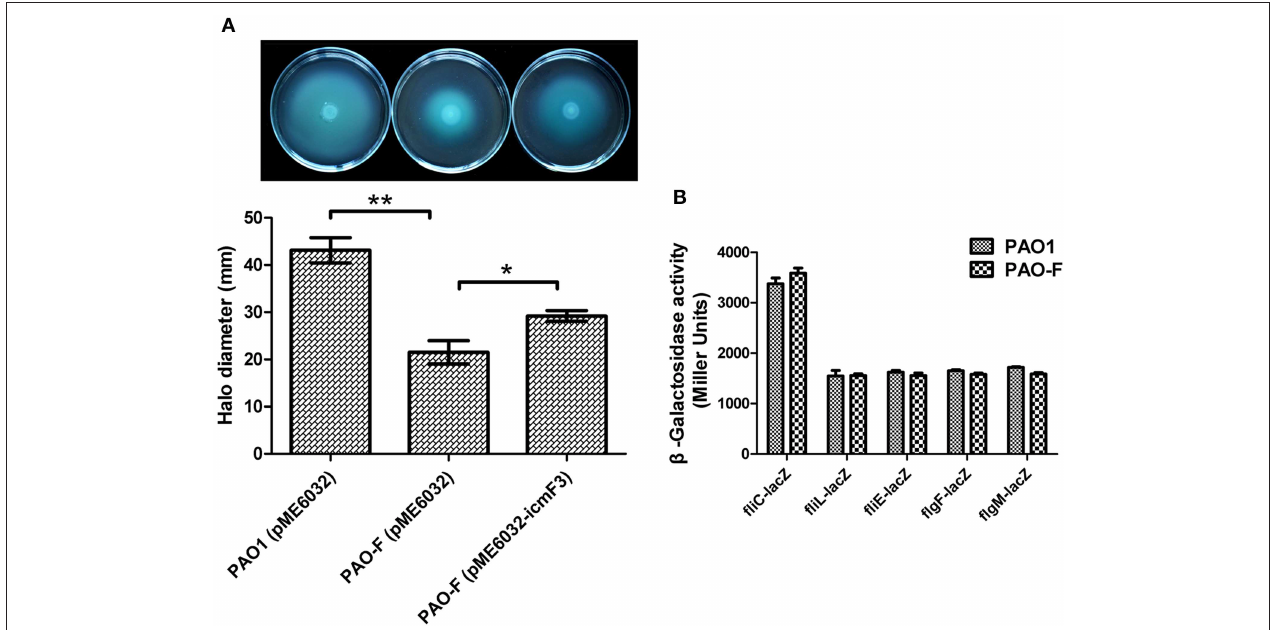
FIGURE 9 | IcmF3 is involved in motility. (A) Motility assay on motility agar plates containing 1mM IPTG and 100 µ g ml − 1 tetracycline after 36h. Halos around the colonies were measured after 36h of incubation at 37 ◦ C. The graph shows the mean and SD of two experiments performed in five replicates each time. * P < 0.05 , ** P < 0.01 . (B) The expression of flagellar biogenesis genes in P. aeruginosa WT and the icmF3 mutant. Levels of fliCfleL , fliLMNOPQRflhB , fliEFGHIJ , flgFGHIJKL , and flgMN transcription in P. aeruginosa WT and the icmF3 mutant were monitored using the fliC-lacZ , fliL-lacZ , fliE - lacZ , flgF - lacZ , and flgM - lacZ transcriptional fusions, respectively. The graphs show the mean and SD of two experiments performed in eight replicates each